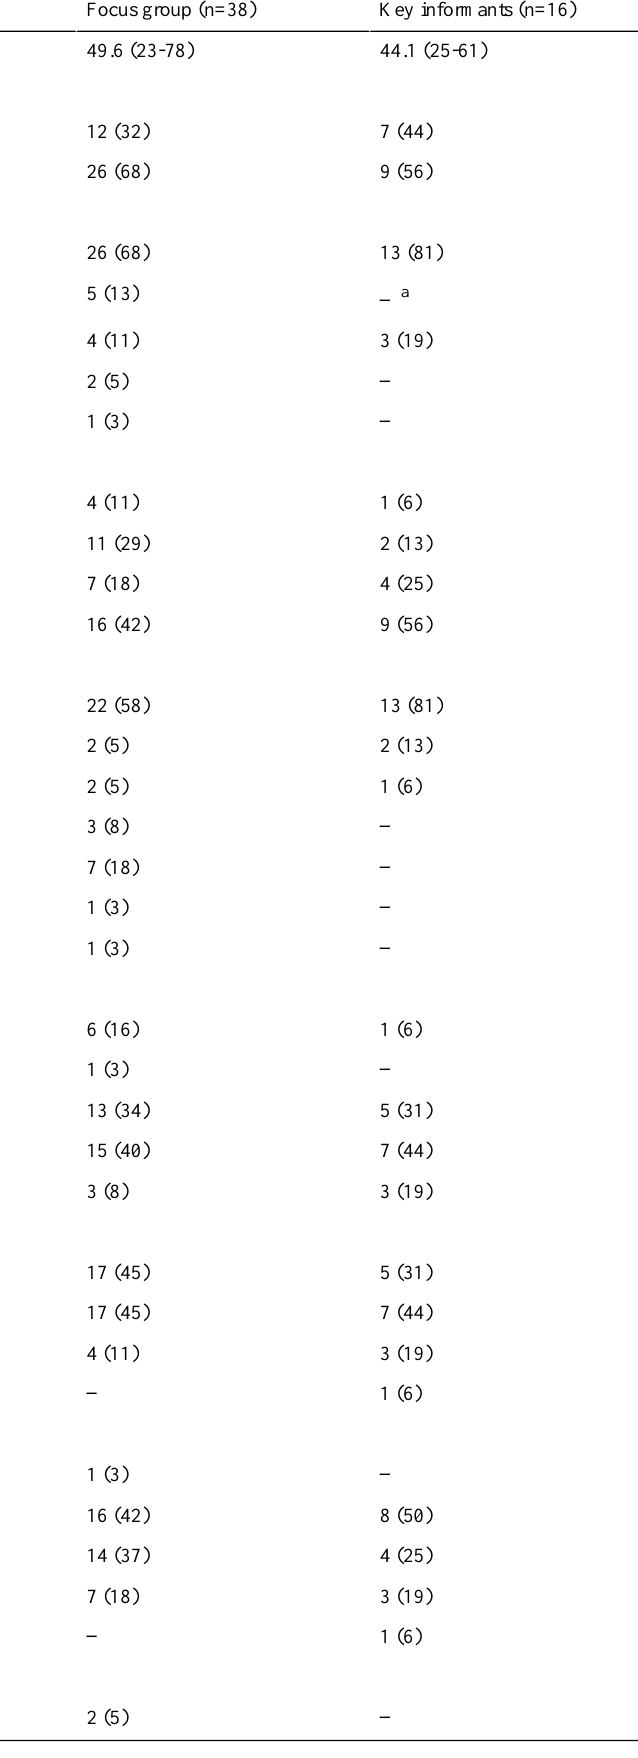
Table 1. Focus group and key informant participants’sociodemographic characteristics and relevant health behaviors (N=54).